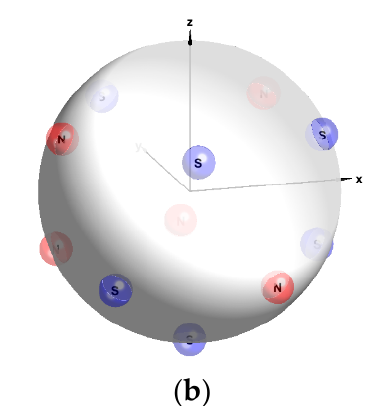
Figure 8. Specifying rotor PM polarities: ( a ) rotor sectors S1 to S5; ( b ) optimal distribution of magnet polarities for 11 magnet locations after removing locations in a solid angle of 0.3789 sr about the z-axis.